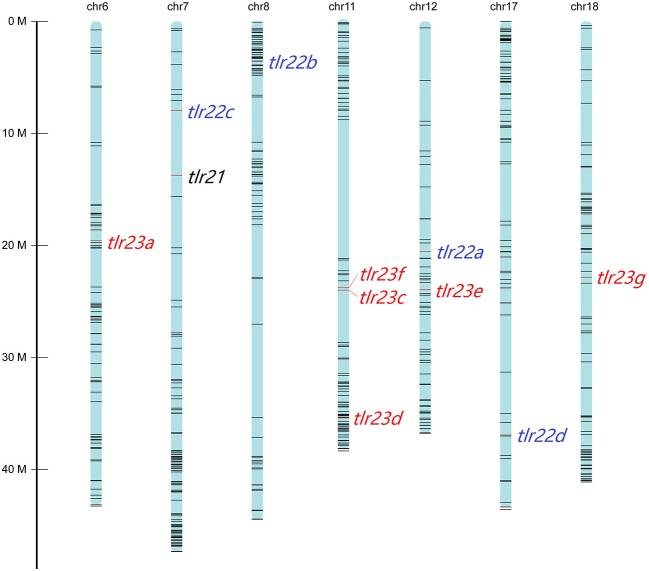
Distributions of tlr21, tlr22, tlr23 paralogues in pseudo-chromosomes of B. pectinirostris. The genes were indicated with red lines. The SNP markers in each chromosome are showed in black lines.